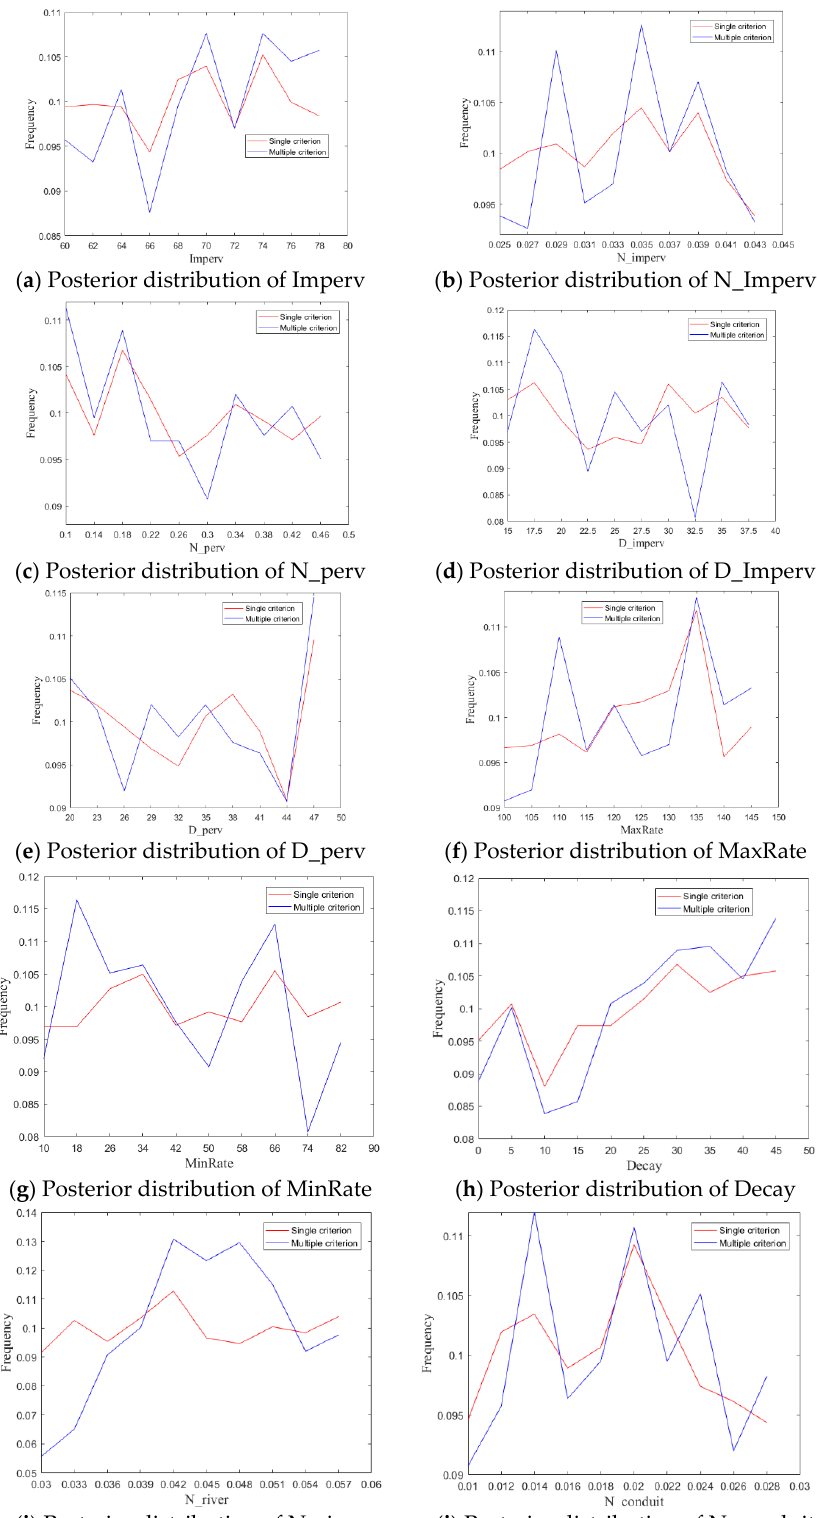
Figure 3. Parameter posterior distribution for single criterion and multiple criteria.